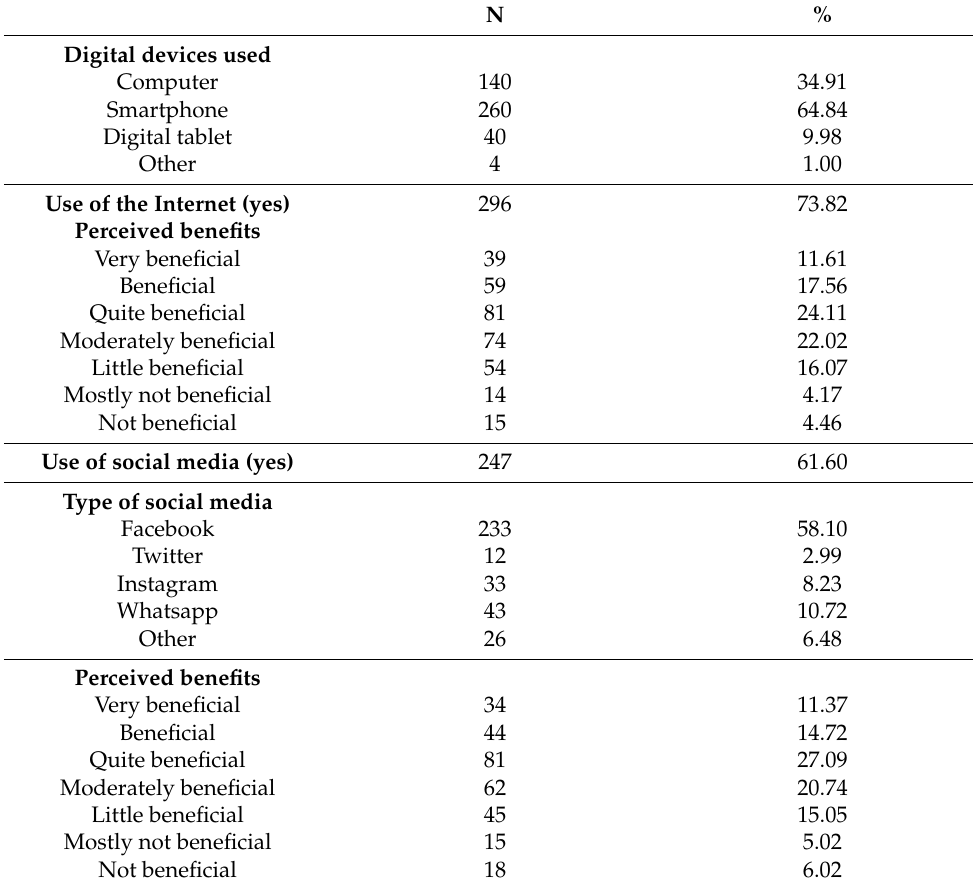
Table 2. Reported use of digital devices and online resources during the bereavement process. N % Digital devices